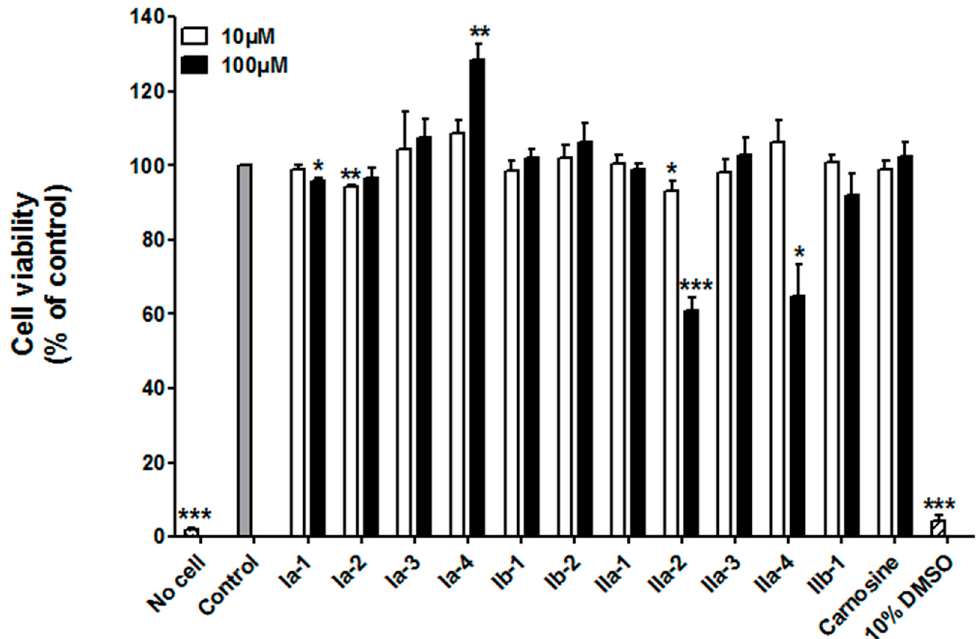
Figure 6. Evaluation of cell viability. PC12 cells were incubated with 10 μ M or 100 μ M of the different multifunctional diamine derivatives for 48 h. DMSO was used as a positive cytotoxicity control. Results are expressed as % of control (non-treated cells). Bars represent the mean ± SEM of at least three independent experiments performed in triplicate. * p < 0.05; ** p < 0.01; *** p < 0.001 vs. control (Student’s t test: p values < 0.05 were considered significant).